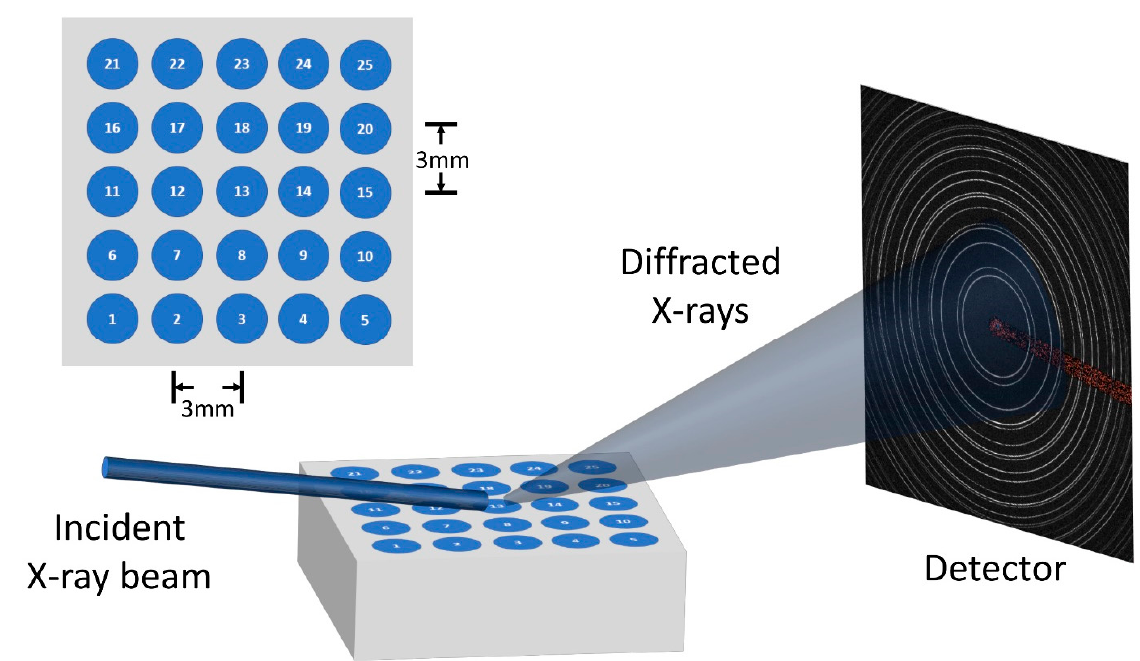
Figure 2. Schematic of the in-house X-ray measurements performed in this study. XRD measurements were conducted with a Bragg–Brentano geometry. A collimated beam with 1 mm beam size was used. XRD data were acquired using an area detector. XRD patterns were acquired at 25 sample positions located on a 5 × 5 grid, as highlighted by the map above.